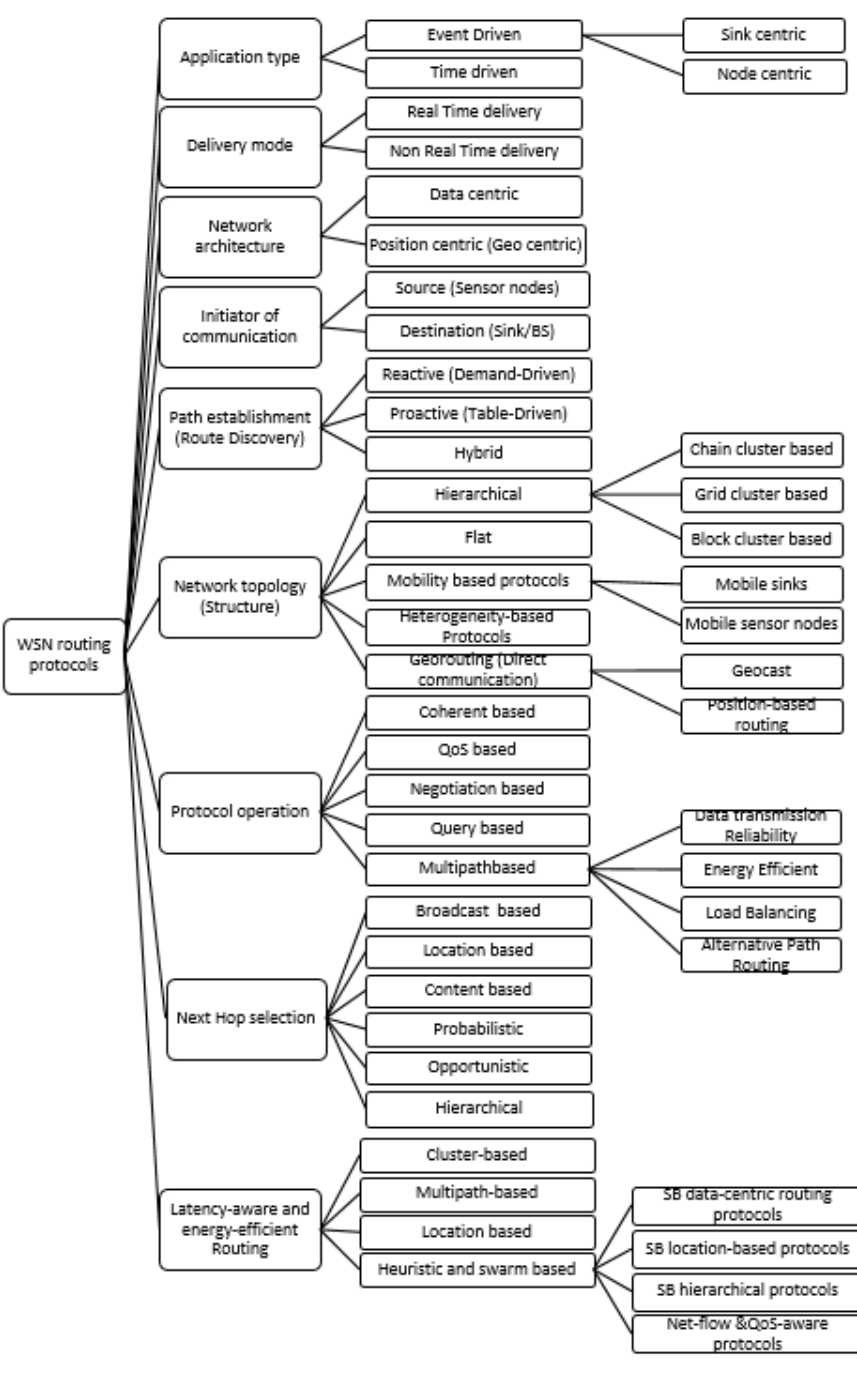
Figure 1. A taxonomy of routing protocols in WSNs.